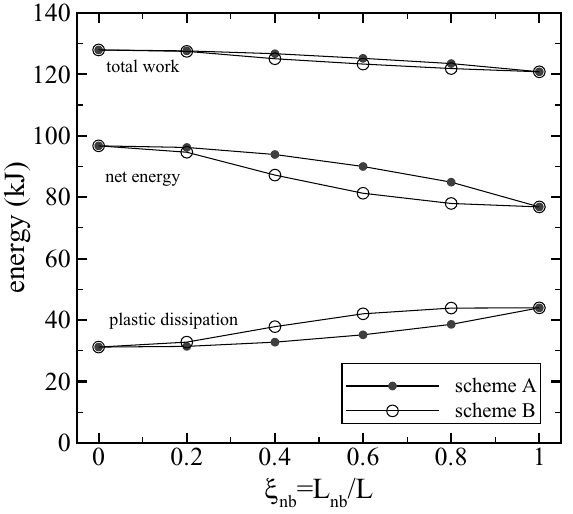
Fig. 21. Influence of the de-bonding ratios on the energy transfer